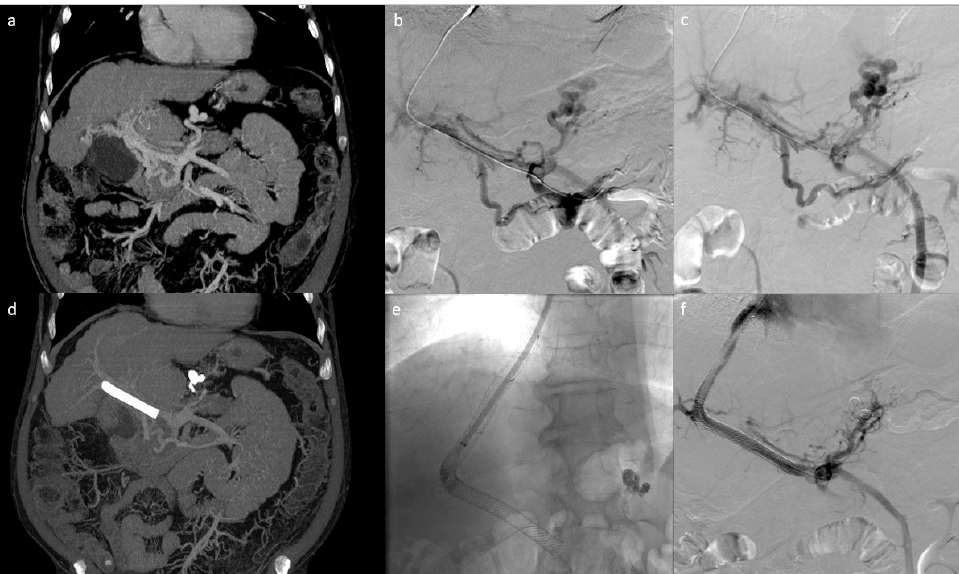
Figure 1. Patient with cavernomatosis and portal hypertension who had episodes of bleeding from gastric varices. ( a ) shows the pre-procedural CT scan with voluminous gastric varices. The patient underwent TIPS and embolization of gastric varices via jugular access. ( b , c ) show the pre-embolization portography; ( e , f ) show the post-embolization portography with TIPS placement; ( d ) shows the post-procedure follow-up CT demonstrating the correct embolization of the gastric varices in the absence of non-target embolizations).